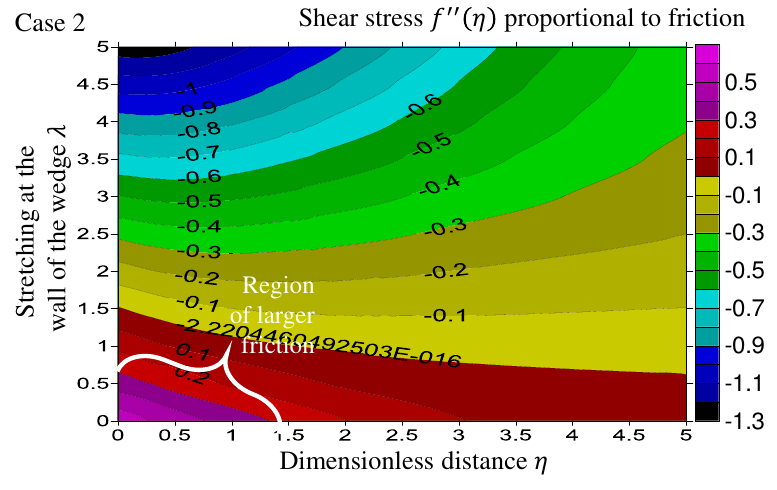
Dimensionless distance (cid:1) Figure 6. Changes in the shear stress function f (cid:48)(cid:48) ( η ) with the wall stretching velocity λ —case